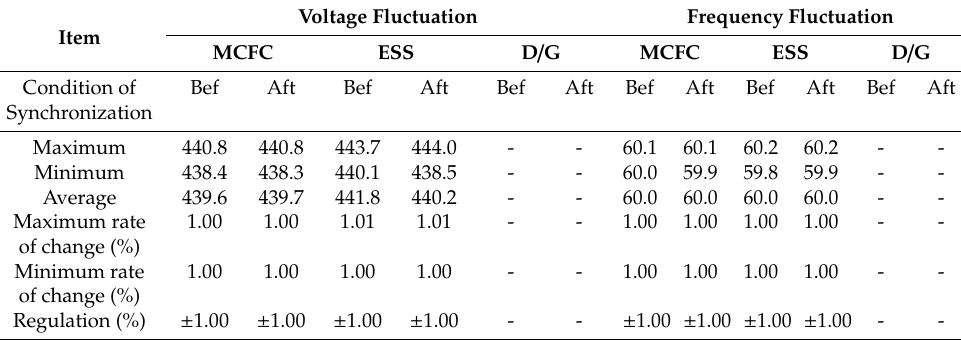
Table 10. Power data analysis before and after ESS